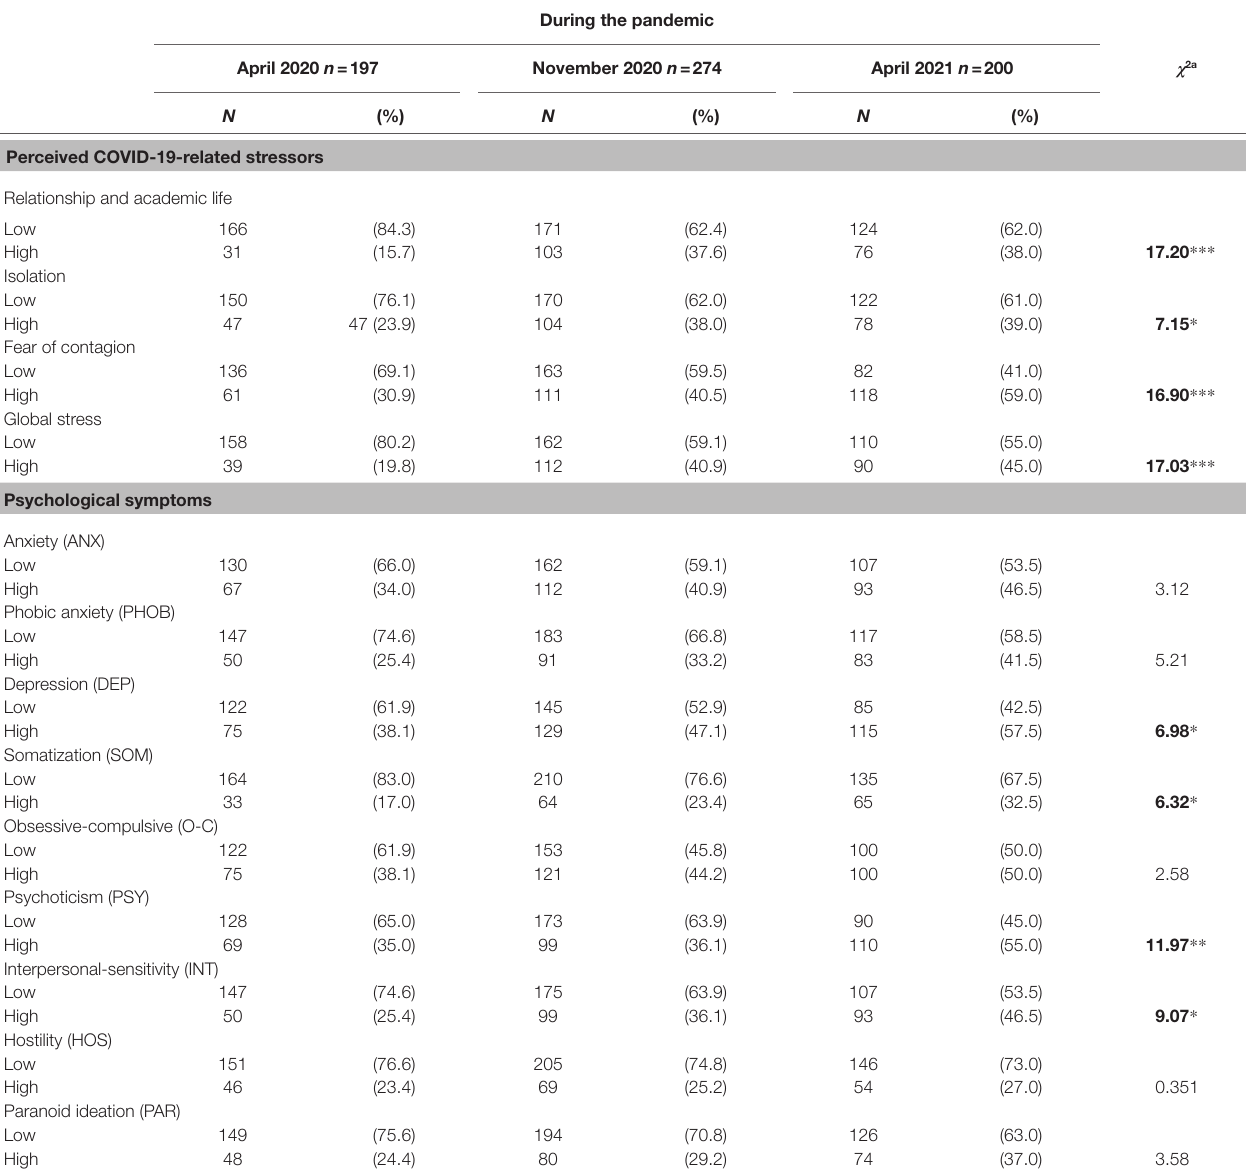
a Cross-tabulations and Chi-Square